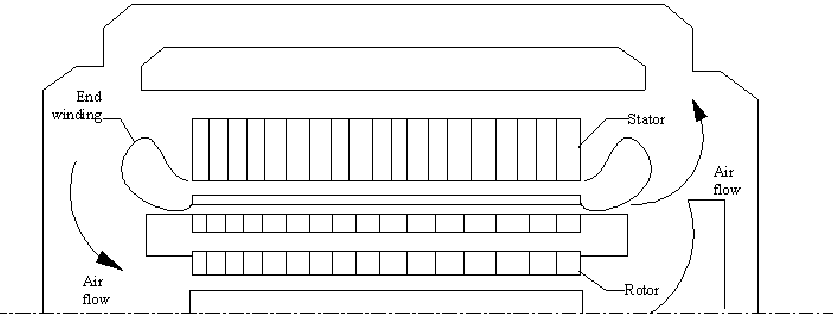
Figure 2. Sketch of the inner construction of a